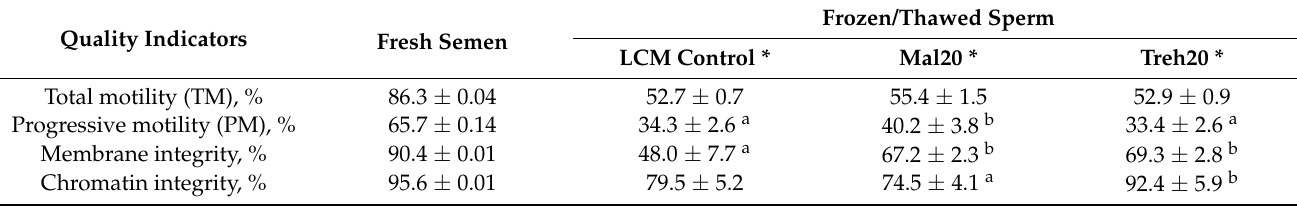
Frozen/Thawed Sperm LCM Control * Mal20 * Treh20 *